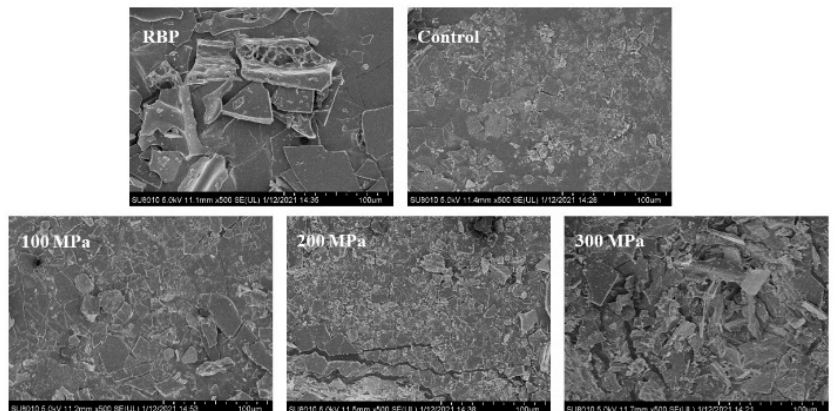
Figure 9. Effect of HHP pretreatment on the surface morphology of RBPH. HHP: high hydrostatic pressure; RBPH: rice bran protein hydrolysates; RBP: rice bran protein. Control, 100 MPa, 200 MPa, and 300 MPa represent RBPH samples subjected to 0, 100, 200, and 300 MPa pretreatment, respectively. All the HHP pretreatments were conducted at 25 °C for 30 min.